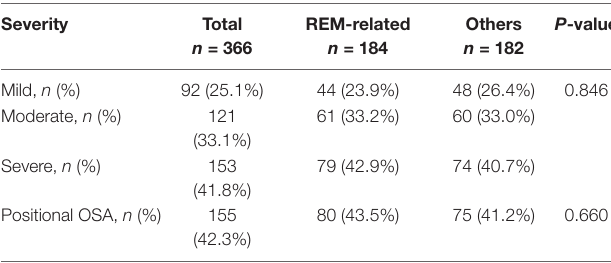
TABLE 2 | Severity of REM related OSA in children comparing other phenotypes.